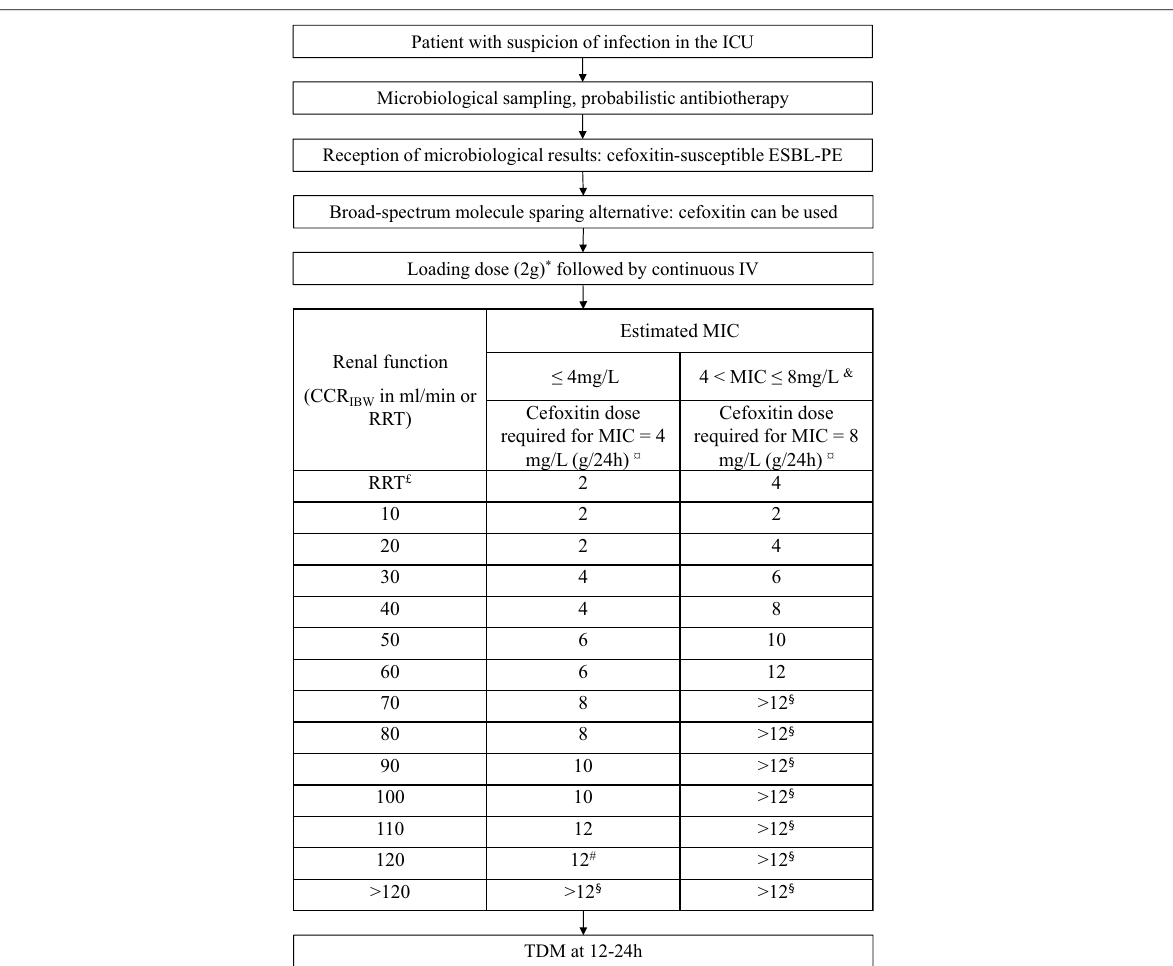
90% for target 100% f T >MIC at 48 h, considering ≥ 120 mL/min and a dose of =